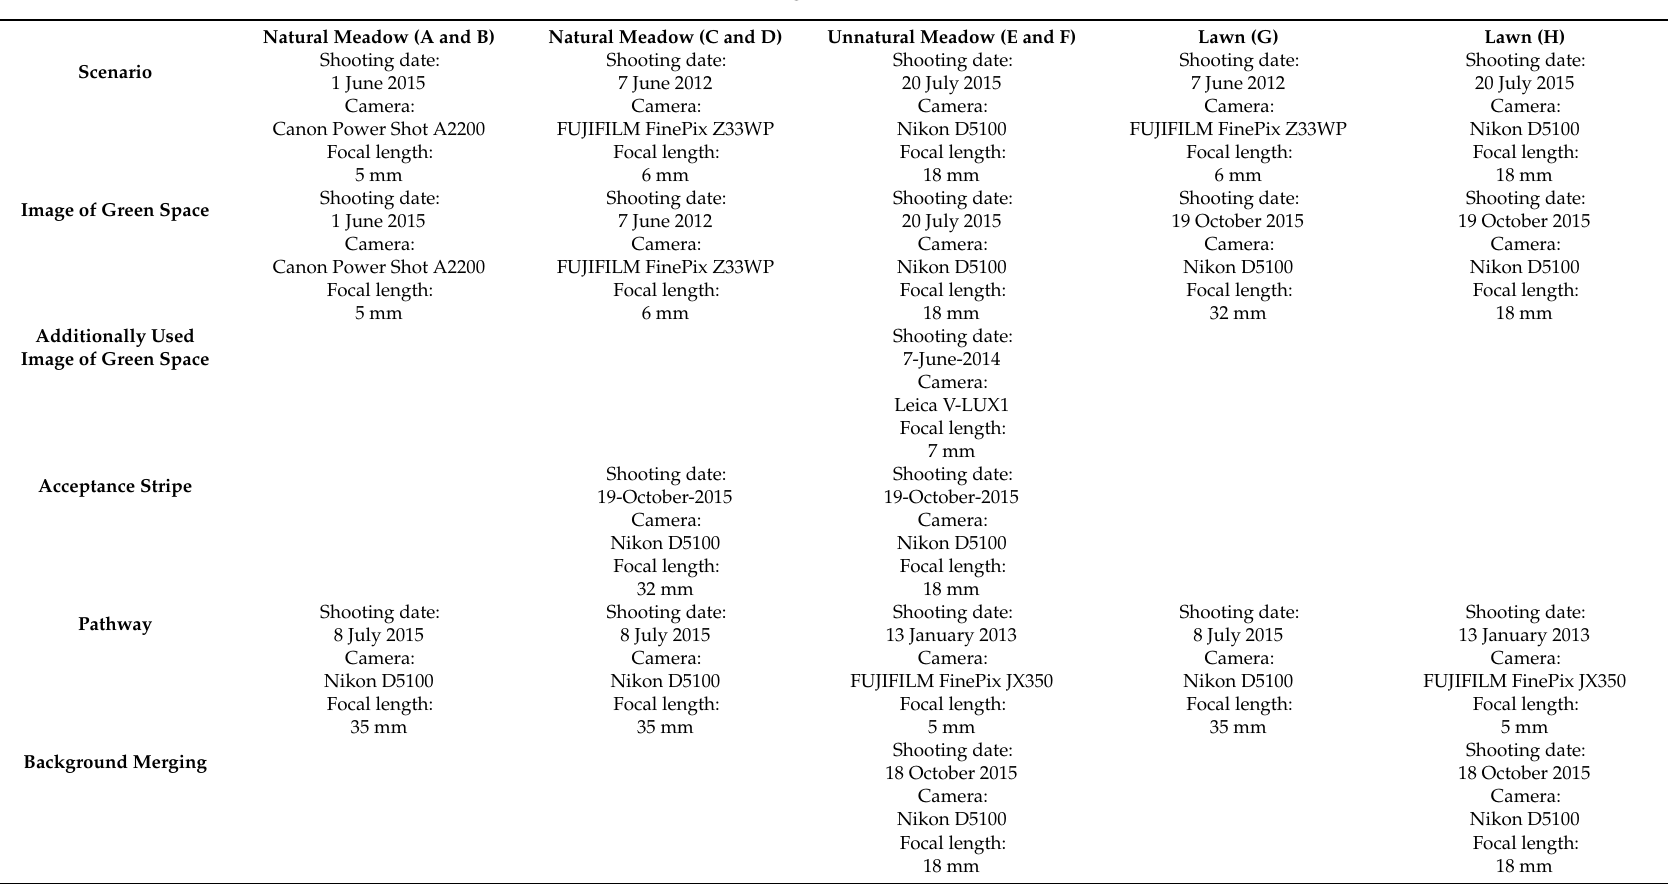
Table A5. Photo usage and details of Question